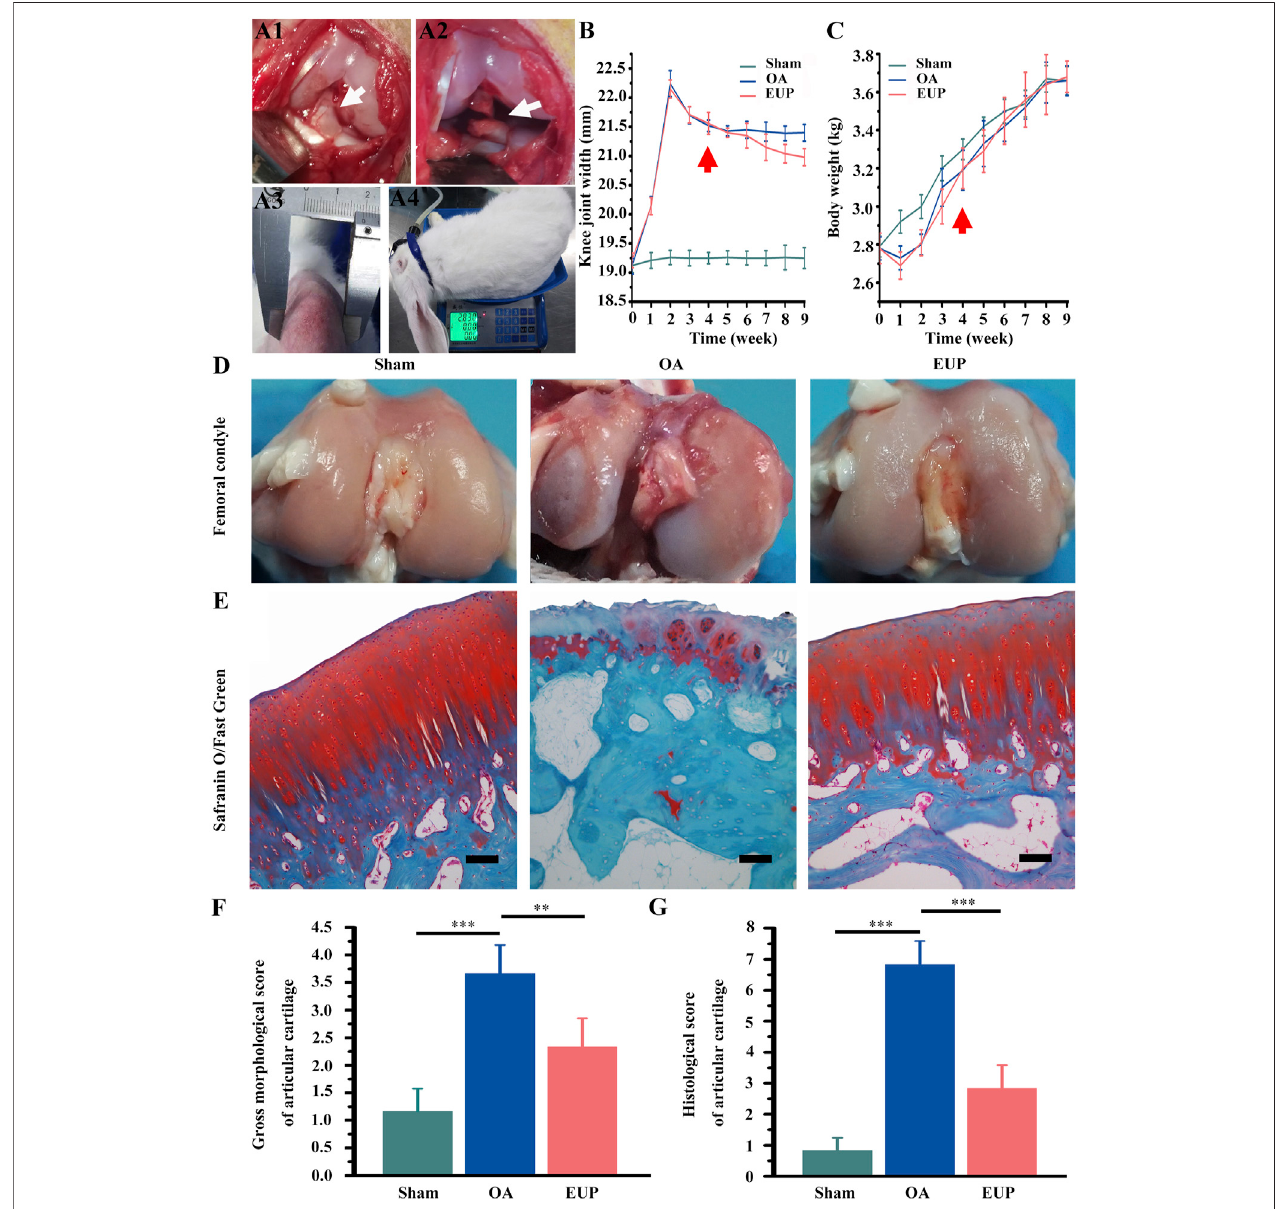
FIGURE 1 | EUP promoted the cartilage repair of rabbit osteoarthritis model constructed by ACLT. (A1) The anterior cruciate ligament (ACL) was exposed, the white arrow pointed to the ACL; (A2) The arrow showed the ACL was cut off; (A3) The width of the rabbit ’ s knee joint was measured by vernier caliper; (A4) Weight measurement. (B) The statistical results of the knee joint width, the arrow showed the administration from the 4 th week. (C) Statistics of rabbit body weight, the arrow showed the administration from the 4 th week. (D) Gross observation of cartilage surface. (E) Staining of articular cartilage with Safranin O/Fast Green, bar represents 100 μ m. (F) Macroscopic morphology evaluation. (G) The score of histological staining. **, *** indicate statistically signi fi cant differences ( p < 0.01 and p < 0.001, respectively). Bar represents 100 μ m.